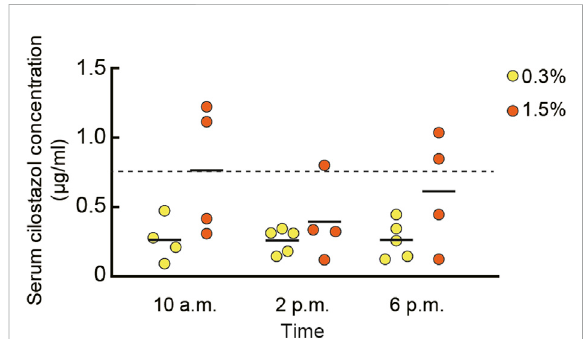
FIGURE 1 Scatter dot plot representing the pharmacokinetics of cilostazol in blood. Blood serum cilostazol concentration in 23- month-old mice was measured after cilostazol administration for 1 month. Blood was collected at 10 a.m., 2 p.m., or 6 p.m. Two-way ANOVA revealed that mean cilostazol concentration in the 1.5% cilostazol group was signi fi cantly higher than that in the 0.3% cilostazol group ( p < 0.01). Horizontal dashed line at 0.76 μ g/ ml represents the clinically effective serum concentration in humans (Takase et al., 2007). Although the serum cilostazol concentration in 1.5% cilostazol group appeared lower than clinically effective threshold at 2 p.m. and 6 p.m., this diurnal variation was not statistically signi fi cant. Four to fi ve mice were used to determine the serum concentration for each cilostazol concentration and time point. As a control, our assay measured 0 g/ml of serum cilostazol in the group that received 0% oral cilostazol. Horizontal bars indicate mean